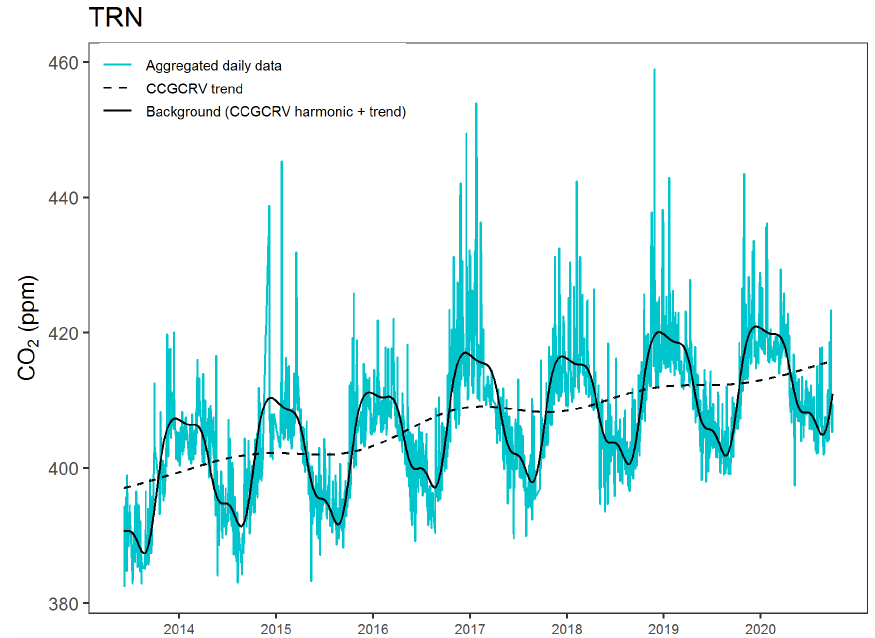
Figure 2. The background signal derived at TRN by combining the harmonic component of the CCGCRV function fit to the data and the long-term trend